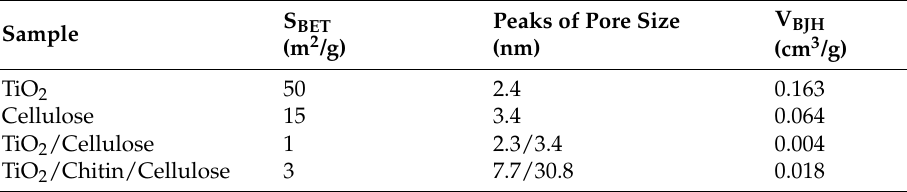
Figure 3. XRD profiles for printed composites, including (a) chitin, (b) pure cellulose, and (c) TiO 2 nanoparticles. Composites with 0.3 g TiO 2 and a weight ratio of cellulose to chitin of (d) 5 g: 0.5 g, (e) 5 g: 1 g, and (f) 5 g: 2 g. Table 1. Structural parameters of the 3D-printed TiO 2 /chitin/cellulose